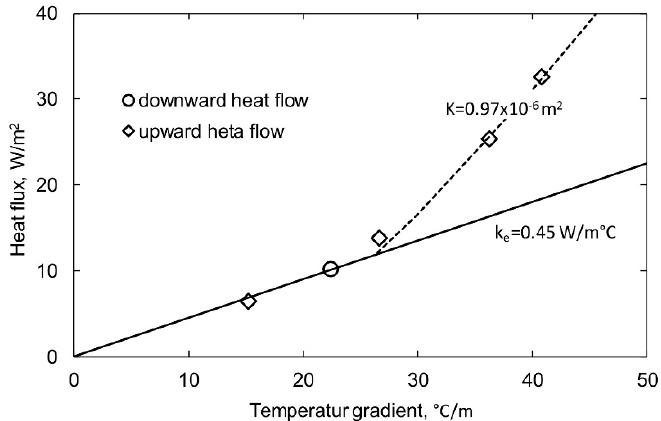
Figure 16. Downward and upward heat flux results for study conducted by Johansen (1975) [2] as represented by Côté et al. (2011) [6].